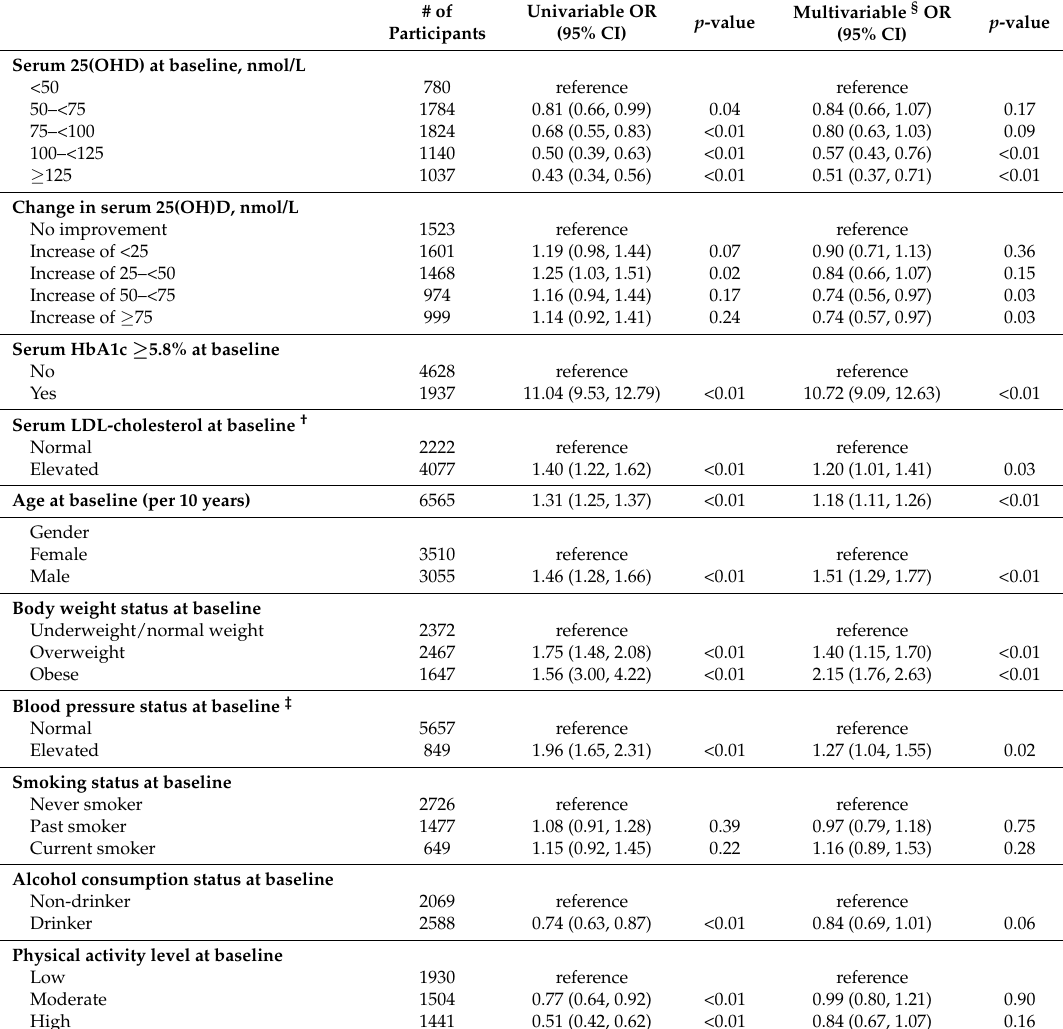
Table 2. Risk for elevated glycated hemoglobin concentration ( ≥ 5.8%) at last follow-up among 6565